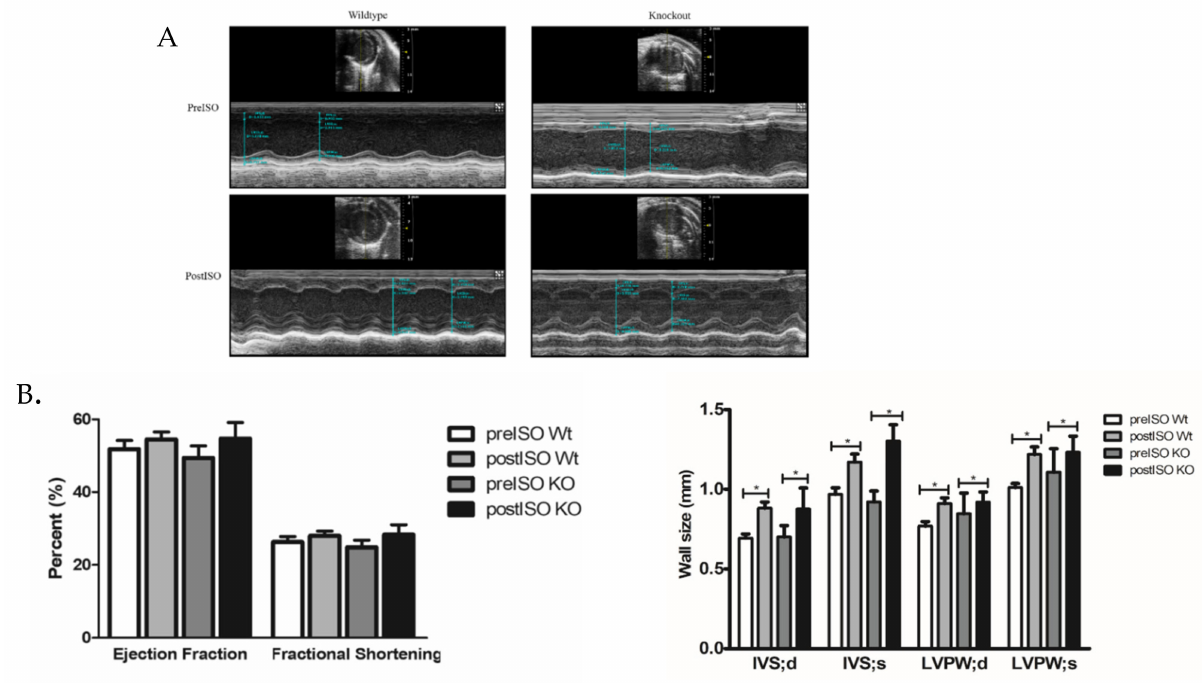
Figure 7. Echocardiography and left ventricular function in ISO challenged Wt and SLMAP3-KO hearts. ( A ) Representative short-axis m-mode images of Wt and KO mice preISO and postISO. ( B ) Left ventricular functional analysis and changes in wall dimensions between pre-/postISO treated Wt and KO hearts. n = 7. * ρ < 0.05, ρ value was calculated using a paired two-way t